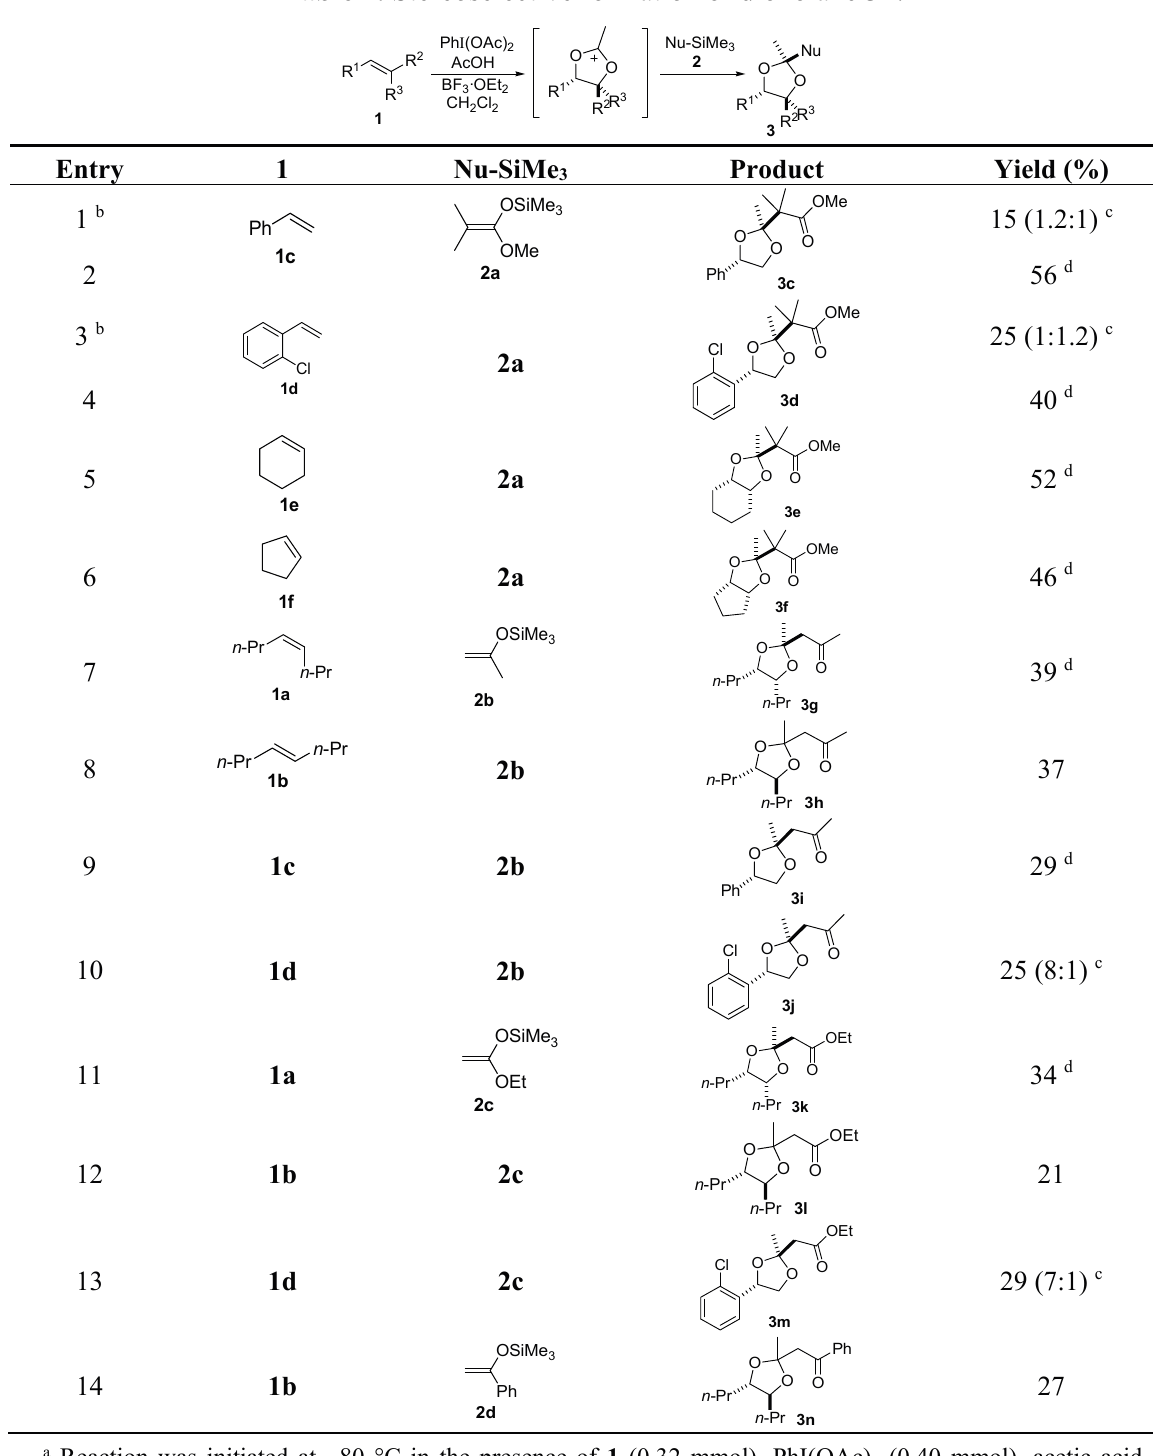
Table 2. Stereoselective formation of dioxolane 3 a